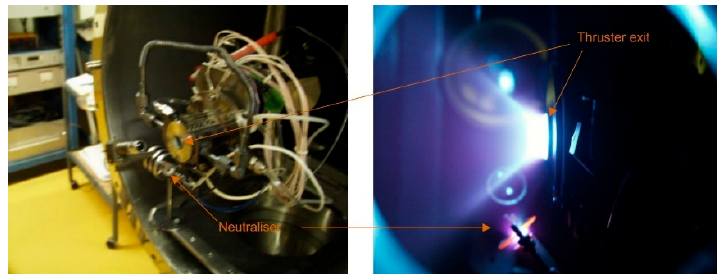
Figure 4. HEMPT prototypes from Thales. Table 2. Performance of HEMPT3050 series.